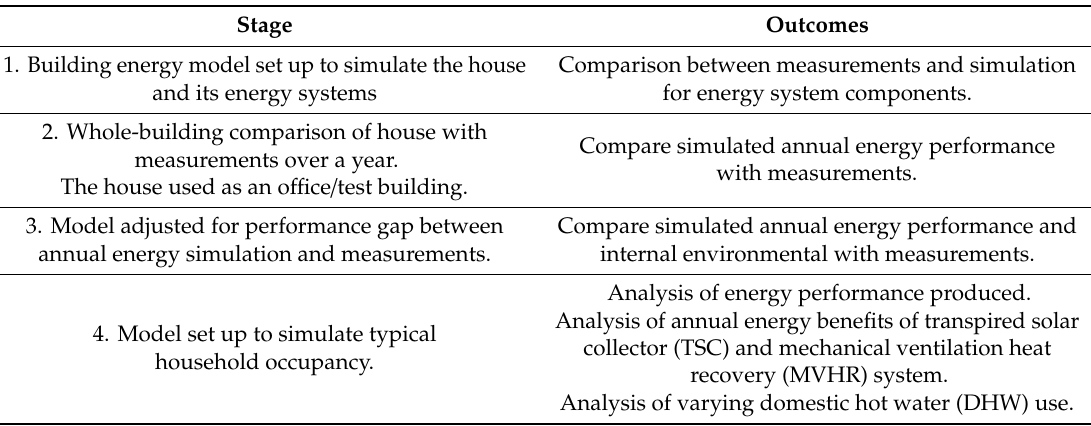
Table 1. Method stages and main outcomes.